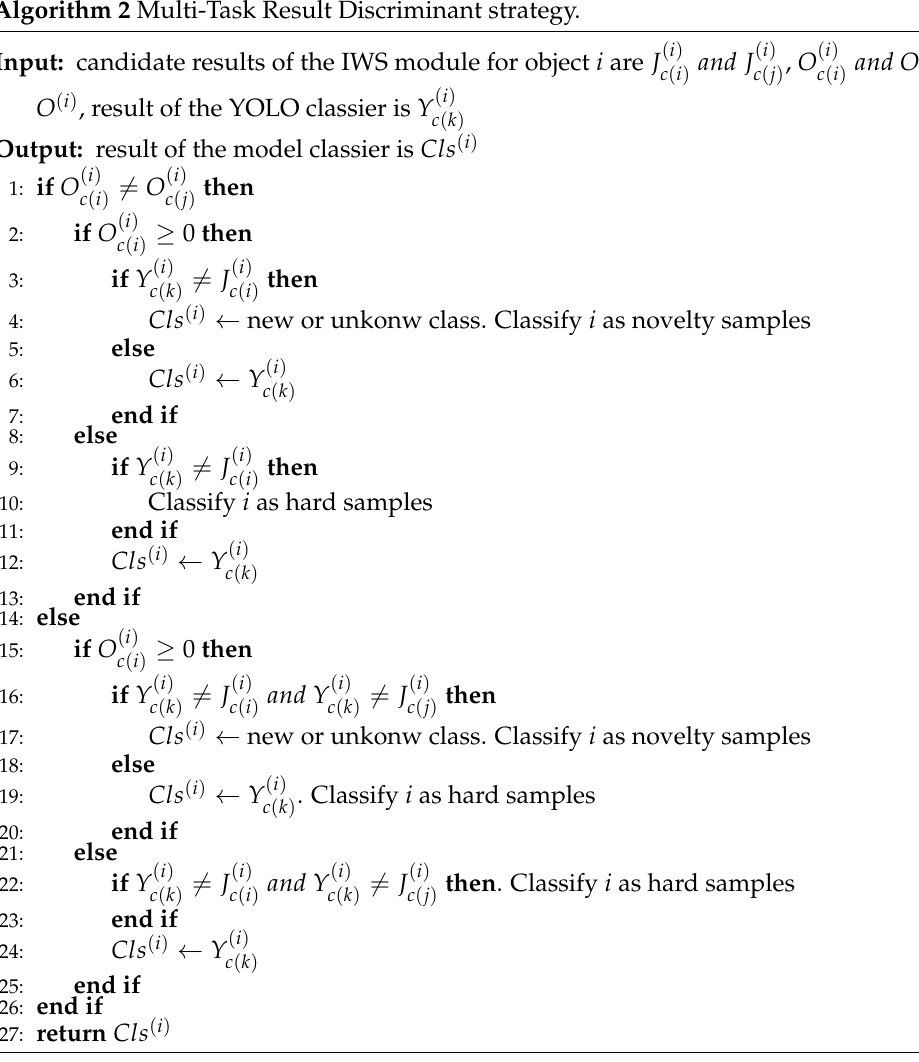
Algorithm 2 Multi-Task Result Discriminant